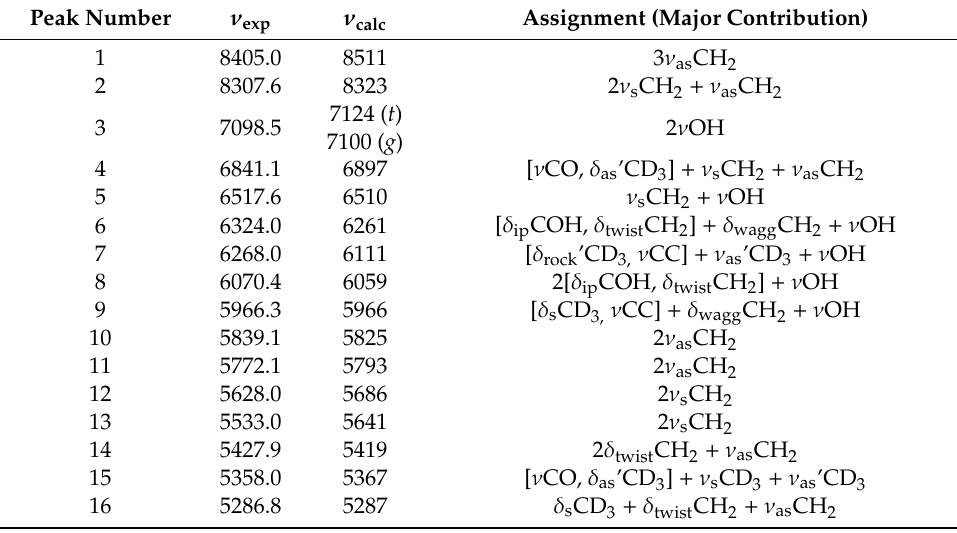
Table 5. Band assignments in NIR spectra of CD 3 CH 2 OH based on GVPT2 // B2PLYP-GD3BJ / def2-TZVP // CPCM calculations. Band numbering corresponds to that presented in Figure